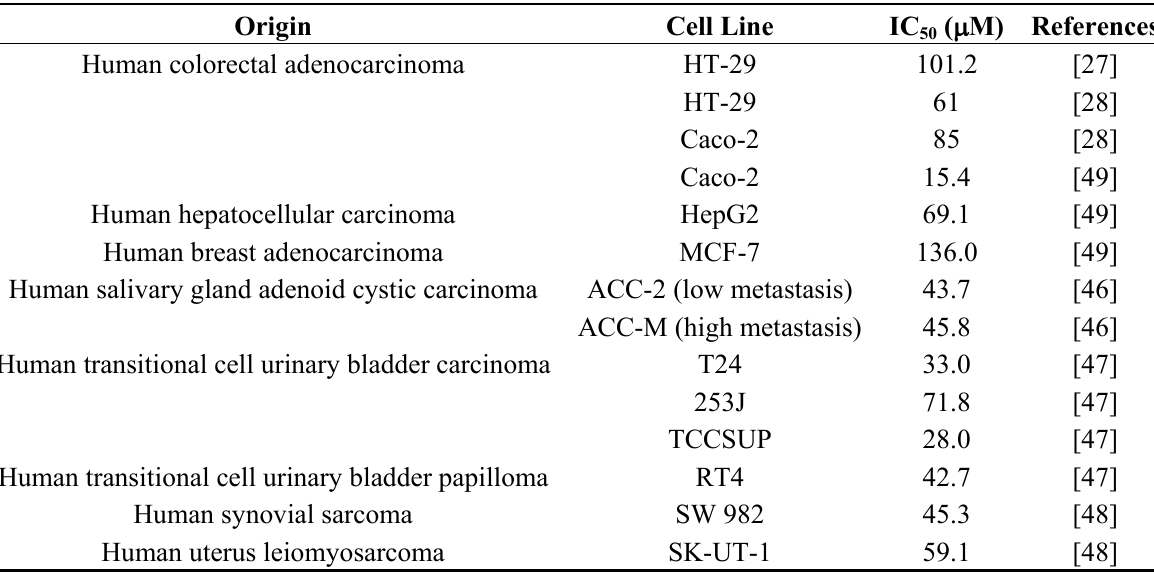
Table 2. In vitro anti-proliferative effect of maslinic